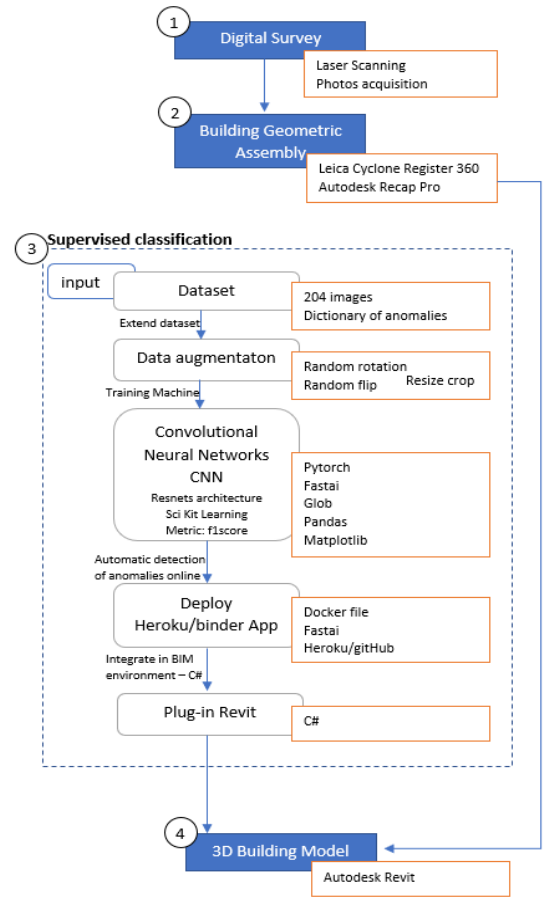
Figure 1. Workflow of the methodology proposed.